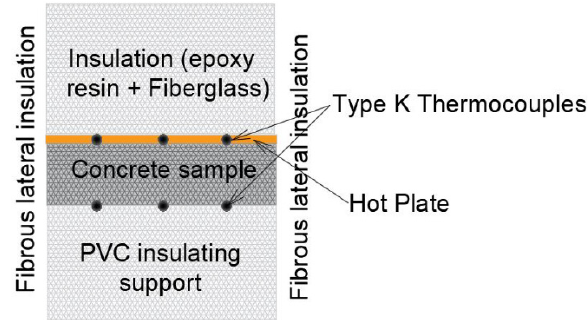
Figure 9. Experimental device .